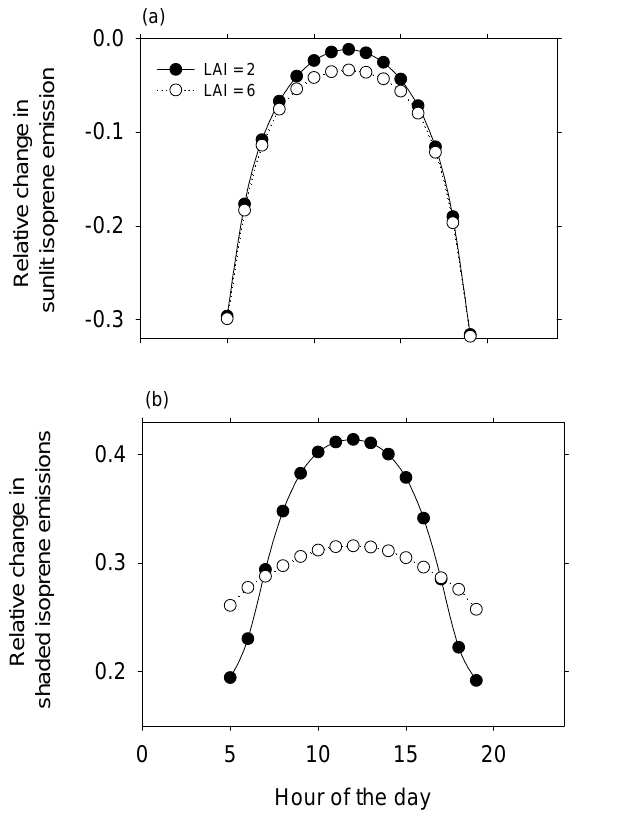
Fig. 6. Relative change in isoprene emission for 1m 2 over the course of a day for (a) sunlit and (b) shaded fractions of the canopy, calculated for an LAI=2 and 6. Relative change is given as [(emis- sions in dusty sky – emissions in clear sky)/emissions in clear sky].